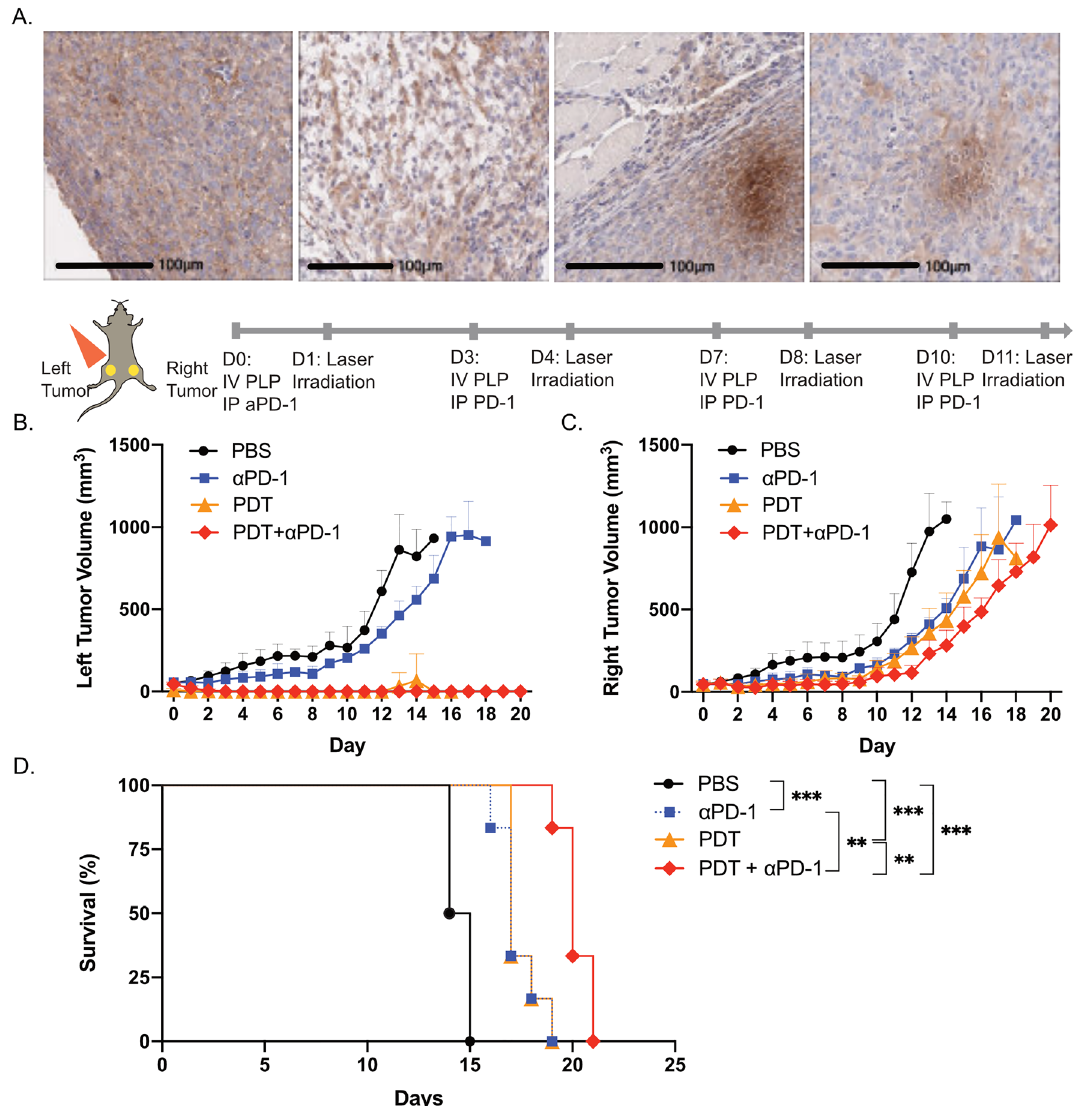
Figure 6: Combination therapy with PDT and α PD-1 antibody treatment improved survival relative to monotherapy. (A)MicroscopicimagesofPD-1stainedAE17-OVA + tumors.DualsubcutaneousAE17-OVA + tumorbearingmiceweretreatedwithfourcyclesof PBS, α PD-1 antibody (12 mg/kg), PDT (PLP at 4 mg/kg), or combination α PD-1 antibody (12 mg/kg) and PDT (PLP at 4 mg/kg). Scale bars represent 100 μ m. (B) Assessment of irradiated, left hindlimb tumors of mice receiving the aforementioned treatments. (C) Assessment of nonirradiated, right hindlimb tumors of mice receiving the aforementioned treatments. (D) Survival of mice receiving the aforementioned treatments. Data are mean ± standard deviation. Statistical signi fi cance of the survival of mice was determined using a one-way